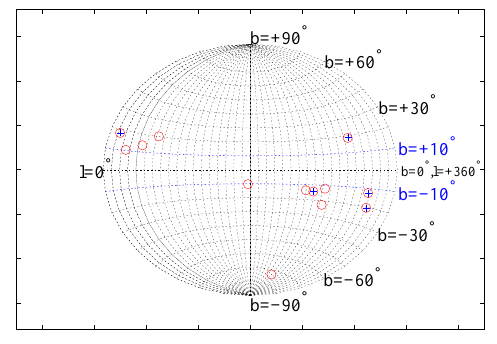
Figure 1: Galactic distribution of the unidentified EGRET sources (circles) and their Fermi-LAT coun- terparts (crosses).